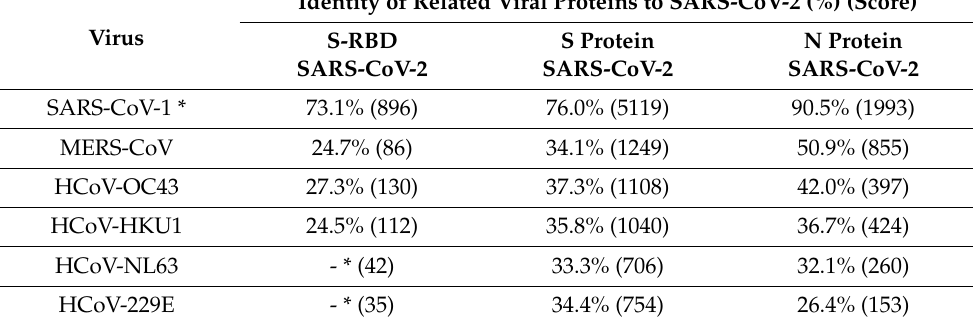
Table 1. Comparison of the Spike-RBD (2nd column), Spike (3rd column), and Nucleocapsid proteins (4th column) of SARS-CoV-2 vs. the other six human infecting coronaviruses. The evaluation is reported in terms of sequence similarity (%) and score (in parentheses). * The similarity between/these two proteins was too low and the comparable sequence was too short to report significant values.